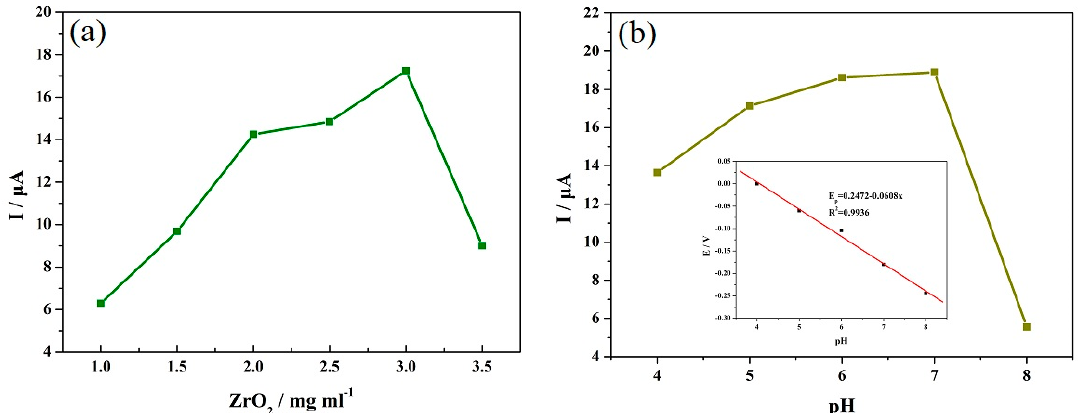
Figure 5. The effects of ( a ) ZrO 2 concentration and ( b ) the pH value on the current response were studied through CV and differential pulse voltammetry (DPV) methods. The inset in Figure 5b shows the effects of pH value on the peak potential.